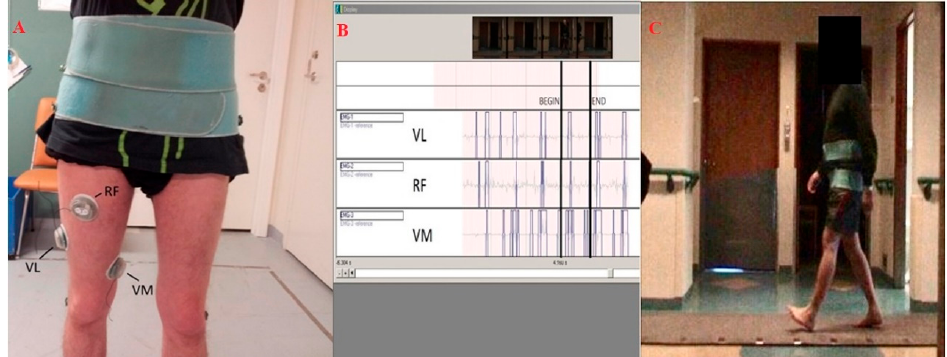
Figure 1. Acquisition of electromyography (EMG) parameters. Starting from the left, the panels show ( A ) the position of the electrodes for the EMG, ( B ) the EMG signals, and ( C ) a patient walking off the platform for the gait analysis. RF = Rectus Femoris, VL = Vastus Lateralis, VM = Vastus Medialis.